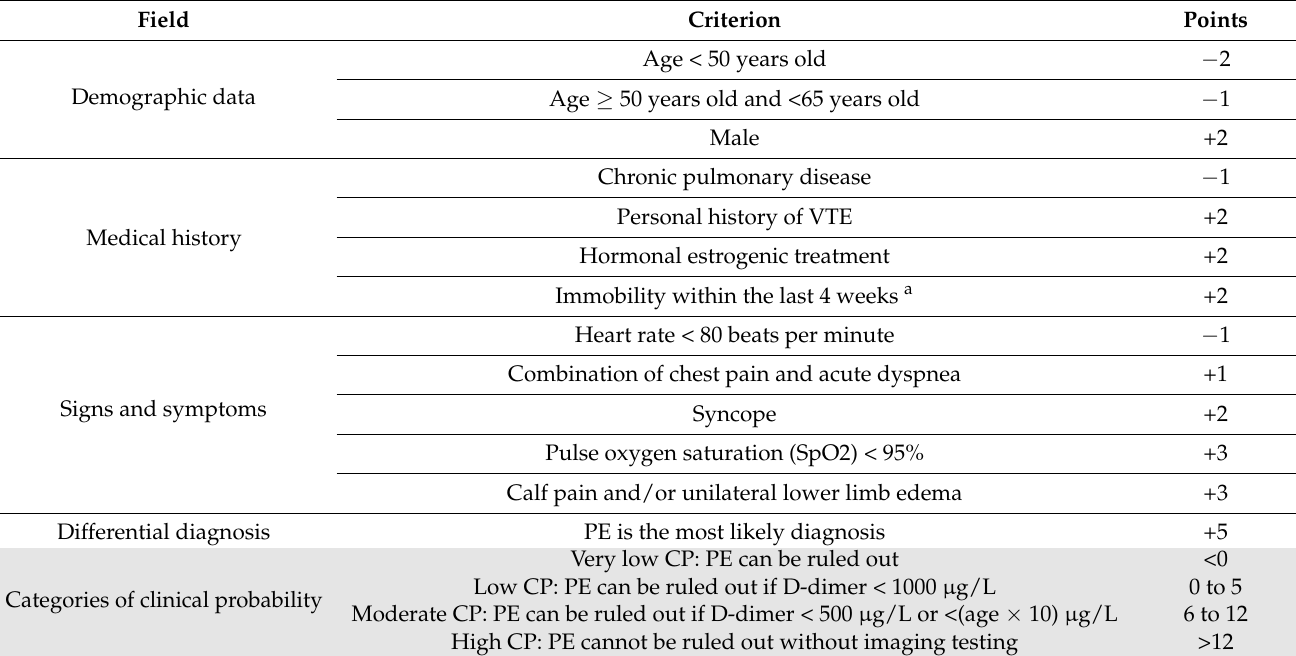
Table 1. 4PEPS or 4-Level Pulmonary Embolism Clinical Probability